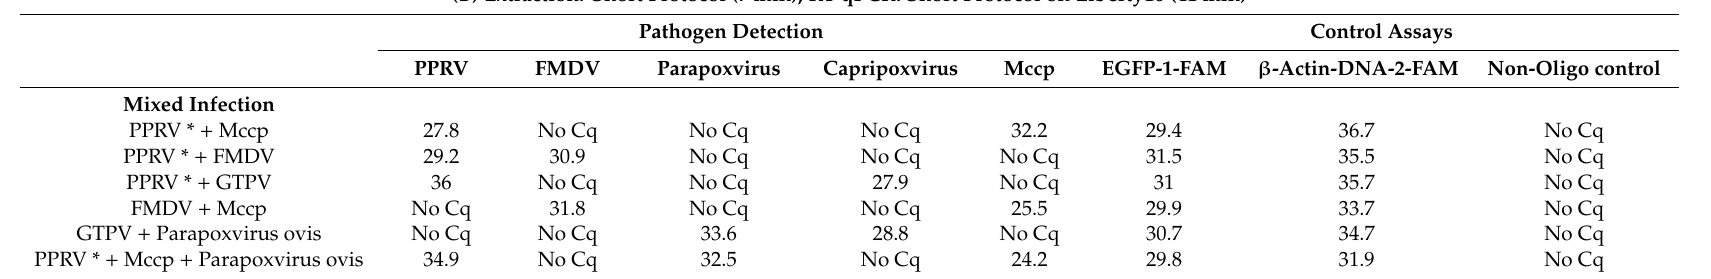
(B) Extraction: Short Protocol (7 min); RT-qPCR: Short Protocol on Liberty16 (41